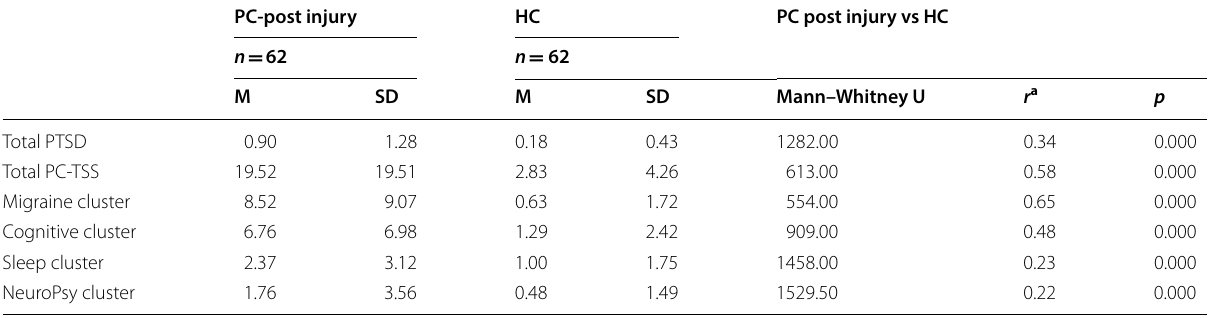
Table 8 Descriptive statistics for both groups are presented below; Mann–Whitney U-tests, effect sizes (d) and significance levels (p) N =